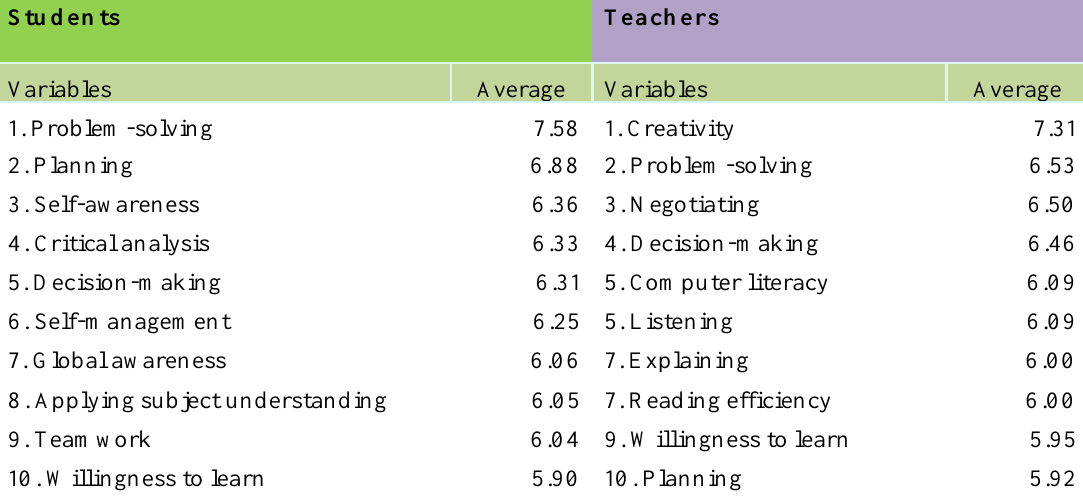
The Ten Most Important